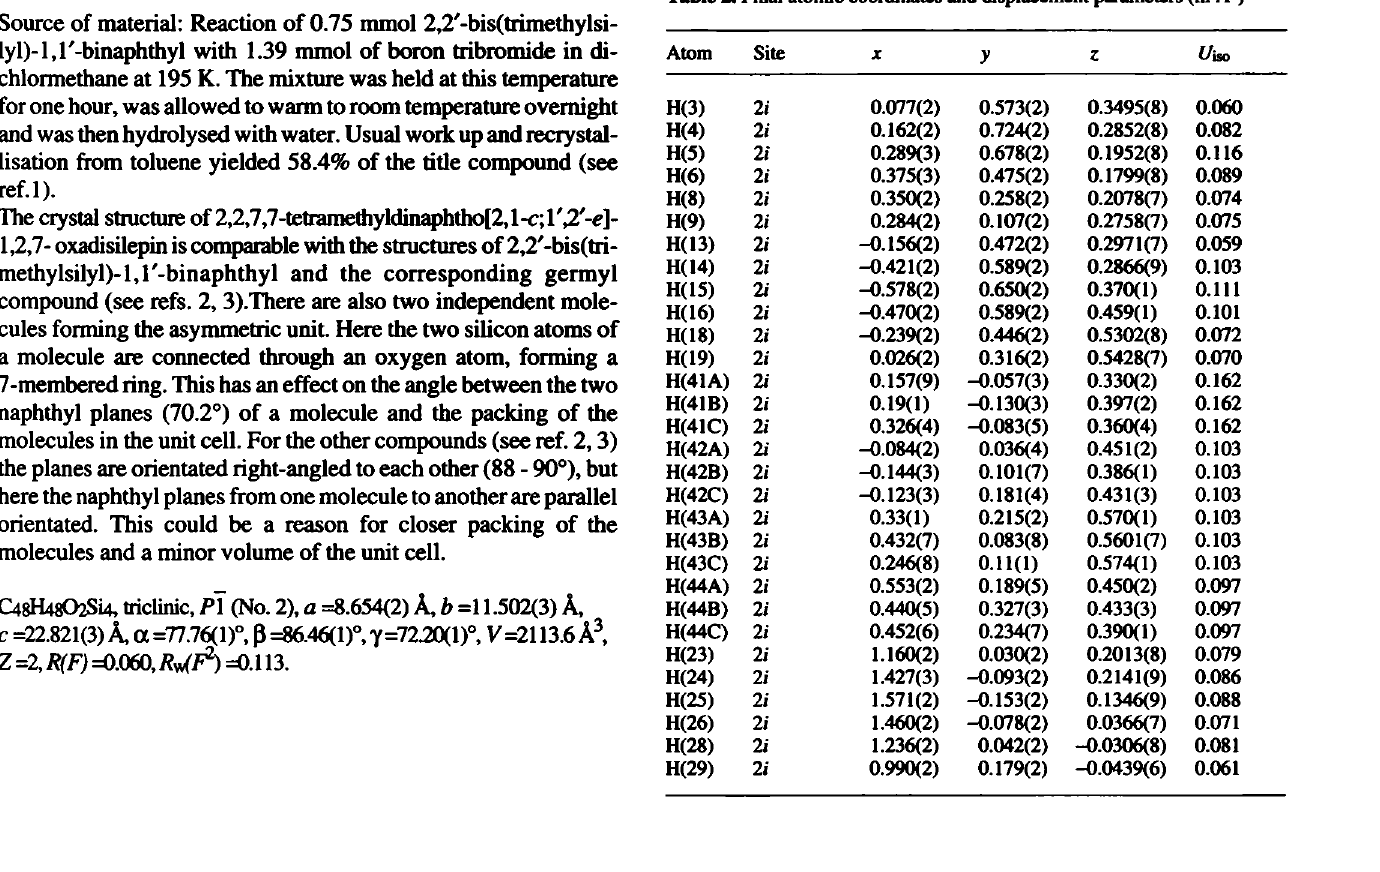
Table 2. Final atomic coordinates and displacement parameters (in Â 2